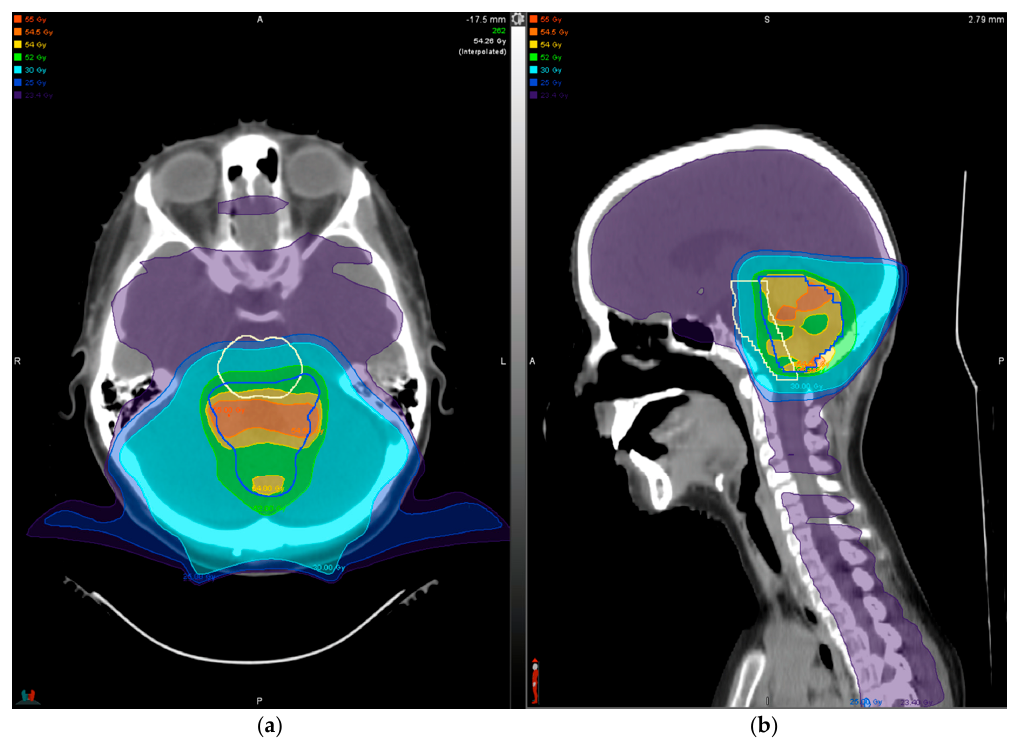
Figure 4. Dose distribution for treatment of standard-risk medulloblastoma shown in axial ( a ) and sagittal ( b ) views. A dose of 23.4 Gy (shaded purple) was delivered to the entire craniospinal